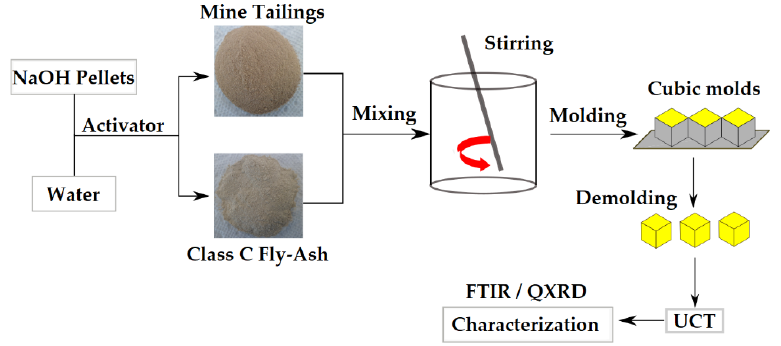
Figure 2. Geopolymer samples production process. Reprinted from Ref. [19].